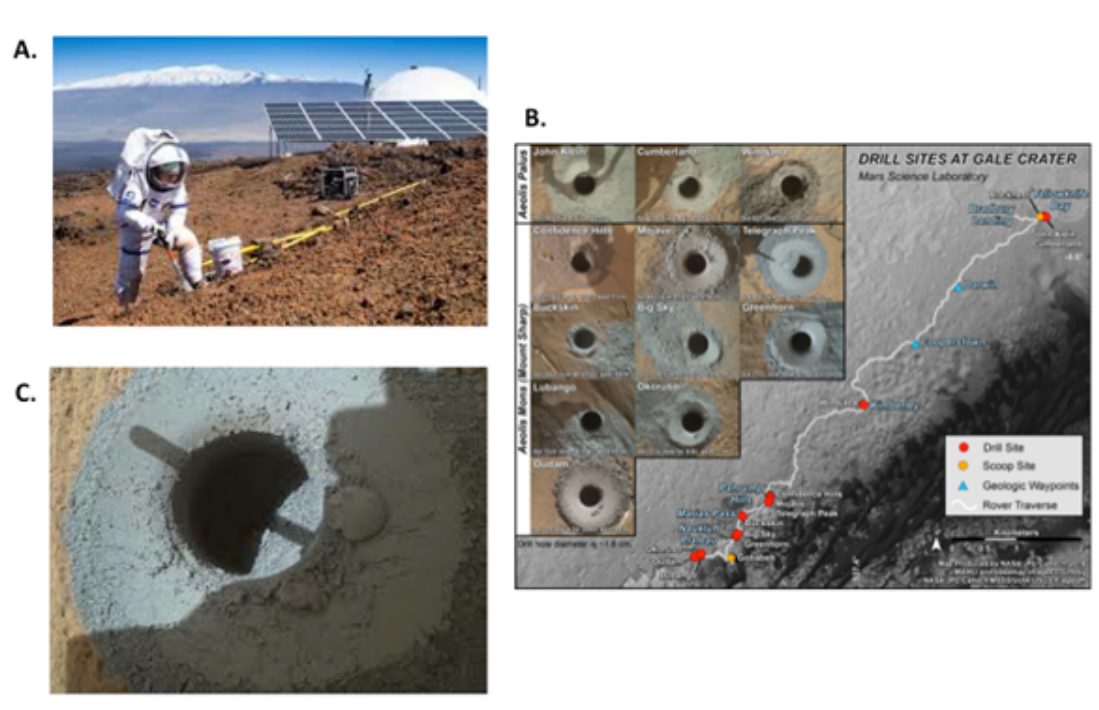
Curiosity drilled sample hole at Telegraph Peak on